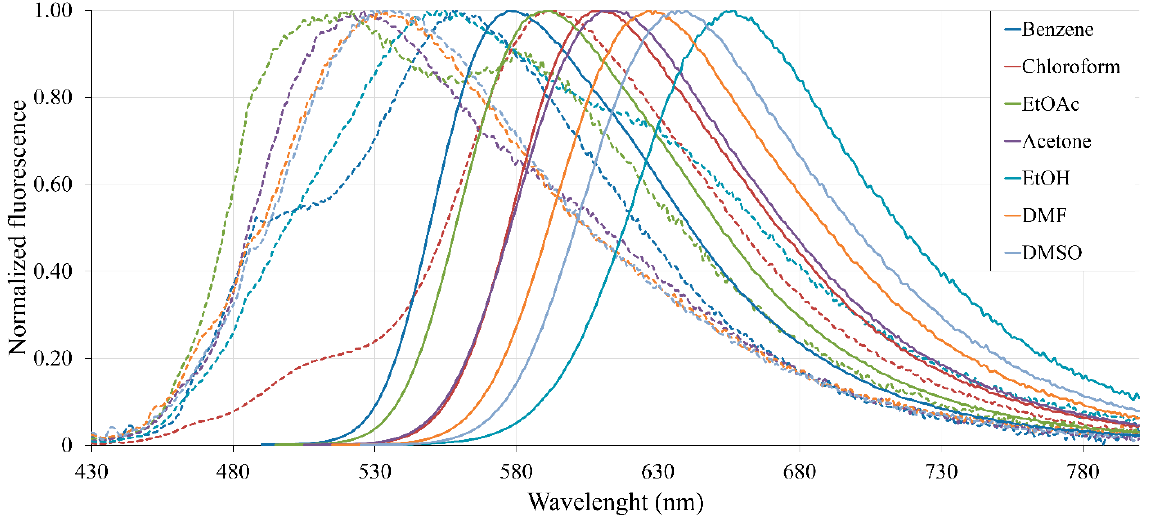
Figure 6. The emission spectra of azomethine 2c (dashed lines) and amine 3c in various organic solvents (concentration 10 − 5 M).